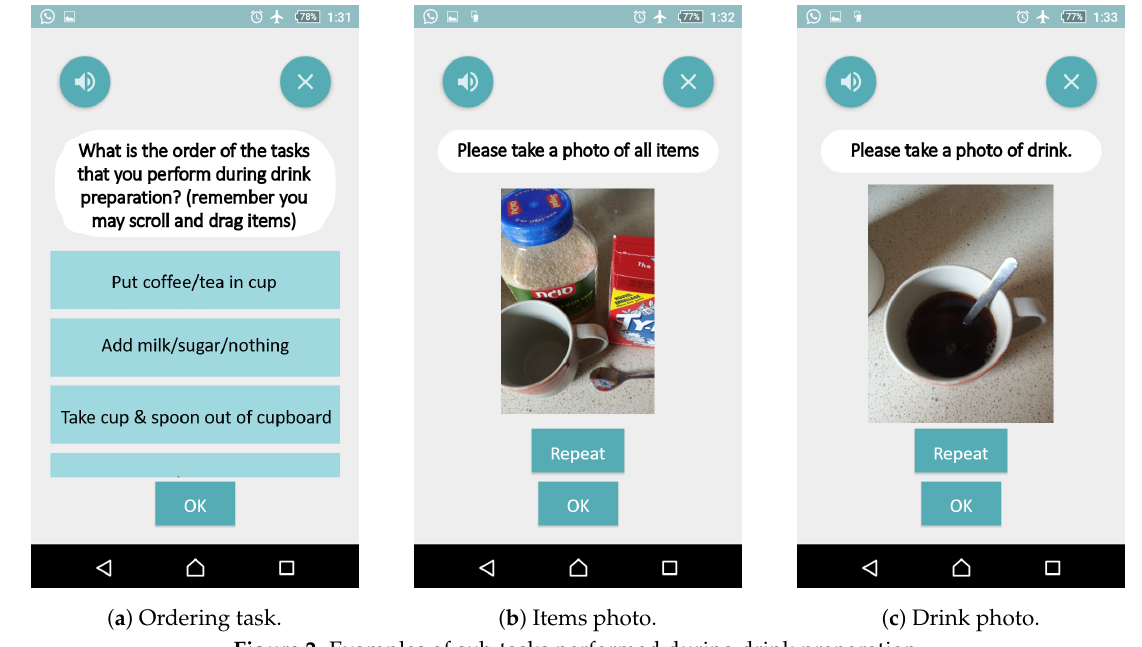
Figure 2. Examples of sub-tasks performed during drink preparation.